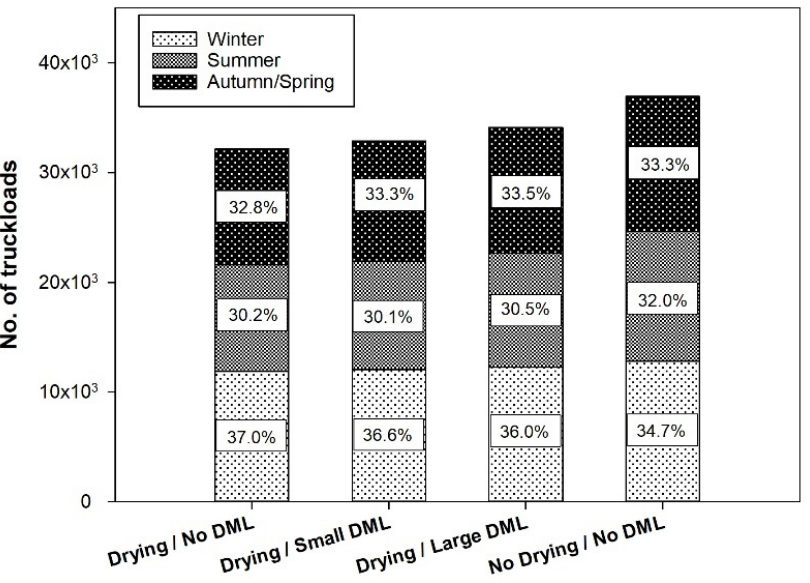
Figure 8. Truckloads of roundwood and residues (bundles) by scenario and season.